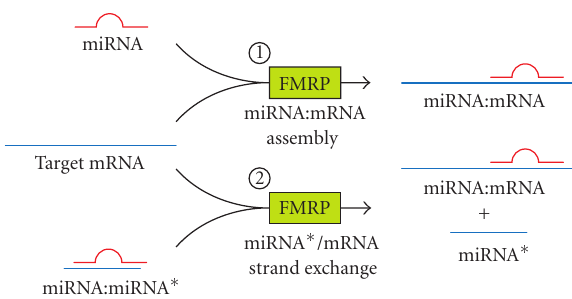
Figure 1: FMRP can assemble and exchange strands of RNAs in- volved in miRNA-guided RNA silencing. Recombinant FMRP can (1) assemble an miRNA to its specific mRNA target, or (2) use an miRNA:miRNA ∗ duplex for mRNA targeting through an RNA strand exchange reaction, which releases the miRNA ∗